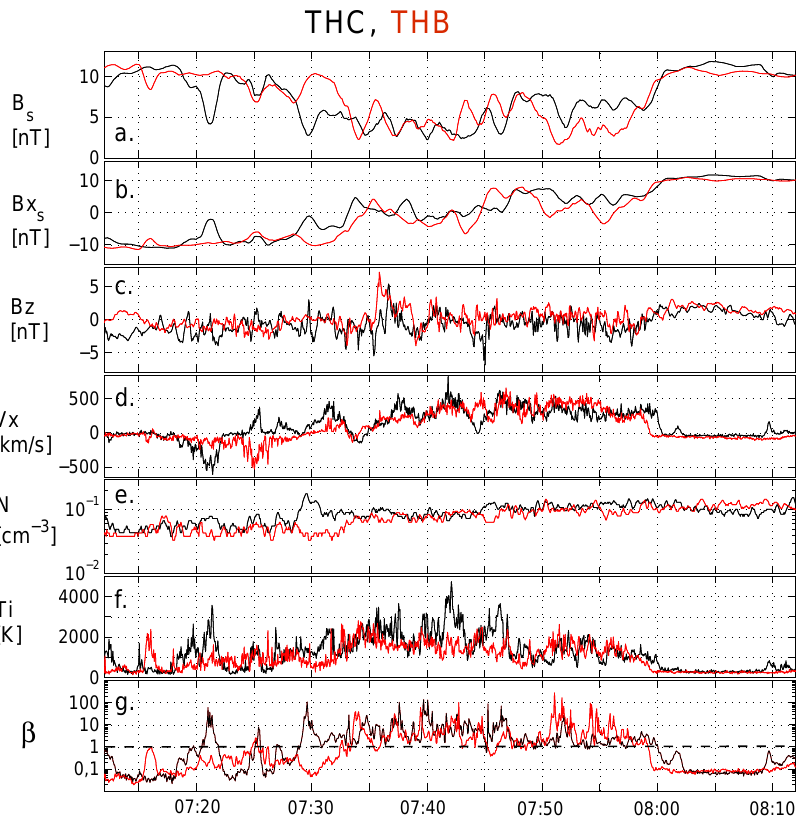
Fig. 3. Comparison of THC (black lines) and THB (red lines) probe measurements; (a) smoothed magnetic field magnitude; (b) smoothed B X magnetic field component; (c) B Z magnetic field component; (d) V X component of the bulk speed; (e) ion density; (f) ion temperature; (g) plasma β